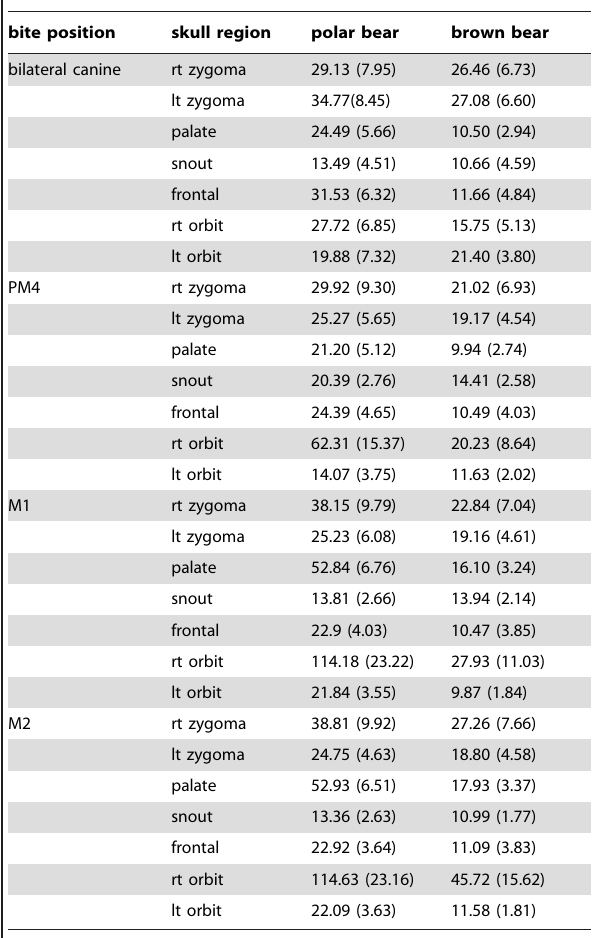
Table 3. Peak Von mises stress for homologous cranial regions in the polar and brown bear models for the four simulated